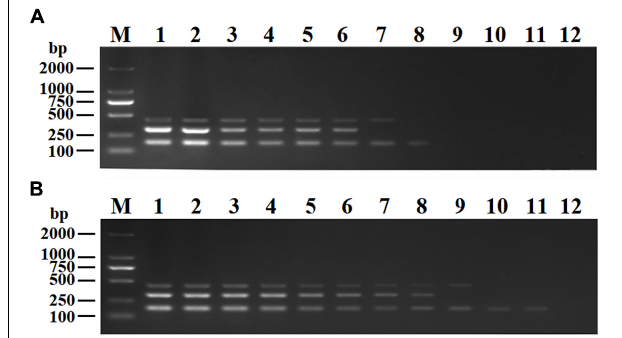
FIGURE 6 | Sensitivity of conventional PCR (A) and DPO-nanoPCR (B) . A serial 10-fold diluted plasmid mixture was used. Lane M, DL2000 DNA marker; Lane 1–11, pMD19-T-VP6 concentrations ranging from 9.40 × 10 10 copies/ µ L to 9.40 × 10 0 copies/ µ L, pMD19-T-VP2 concentrations ranging from 5.14 × 10 10 copies/ µ L to 5.14 × 10 0 copies/ µ L, and pMD19-T-5 (cid:48) UTR concentrations ranging from 4.09 × 10 11 to 4.09 × 10 1 copies/ µ L; Lane 12, negative control.